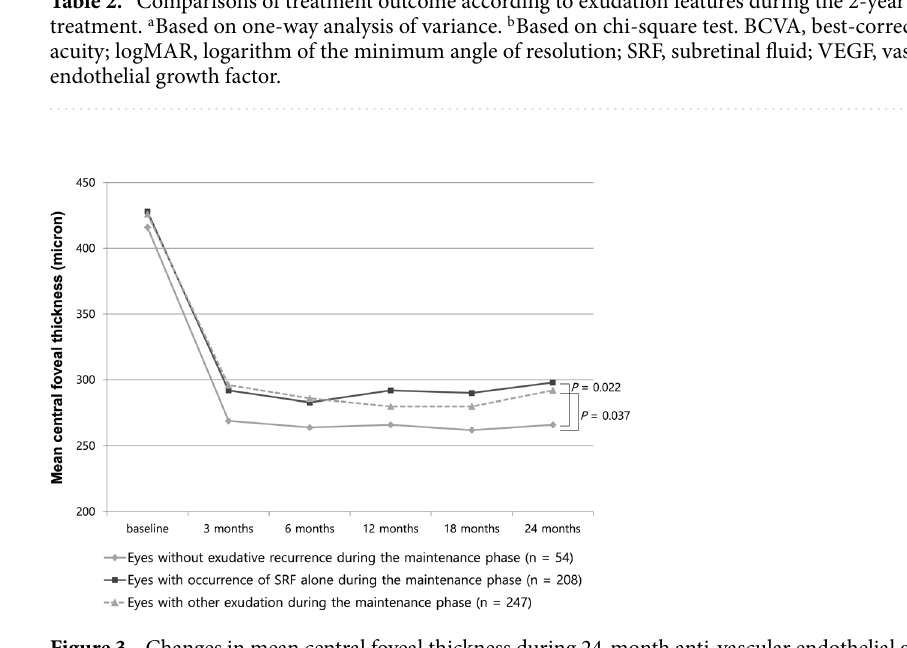
Figure 3. Changes in mean central foveal thickness during 24-month anti-vascular endothelial growth factor treatment for neovascular age-related macular degeneration. The mean central foveal thickness showed a significant decrease from baseline to 24 months in all groups. After the 24-month treatment, central foveal thickness of eyes without exudative recurrence was significantly thinner than that of eyes with occurrence of SRF alone (P = 0.022) and eyes with exudation except for cases of SRF alone ( P = 0.037; Bonferroni correction after one-way analysis of